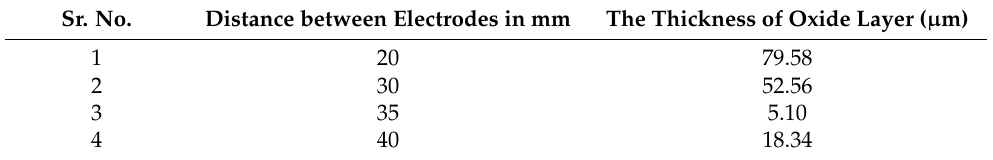
Table 4. The oxide layer thickness values as per variation in the distance between the electrodes. Sr.